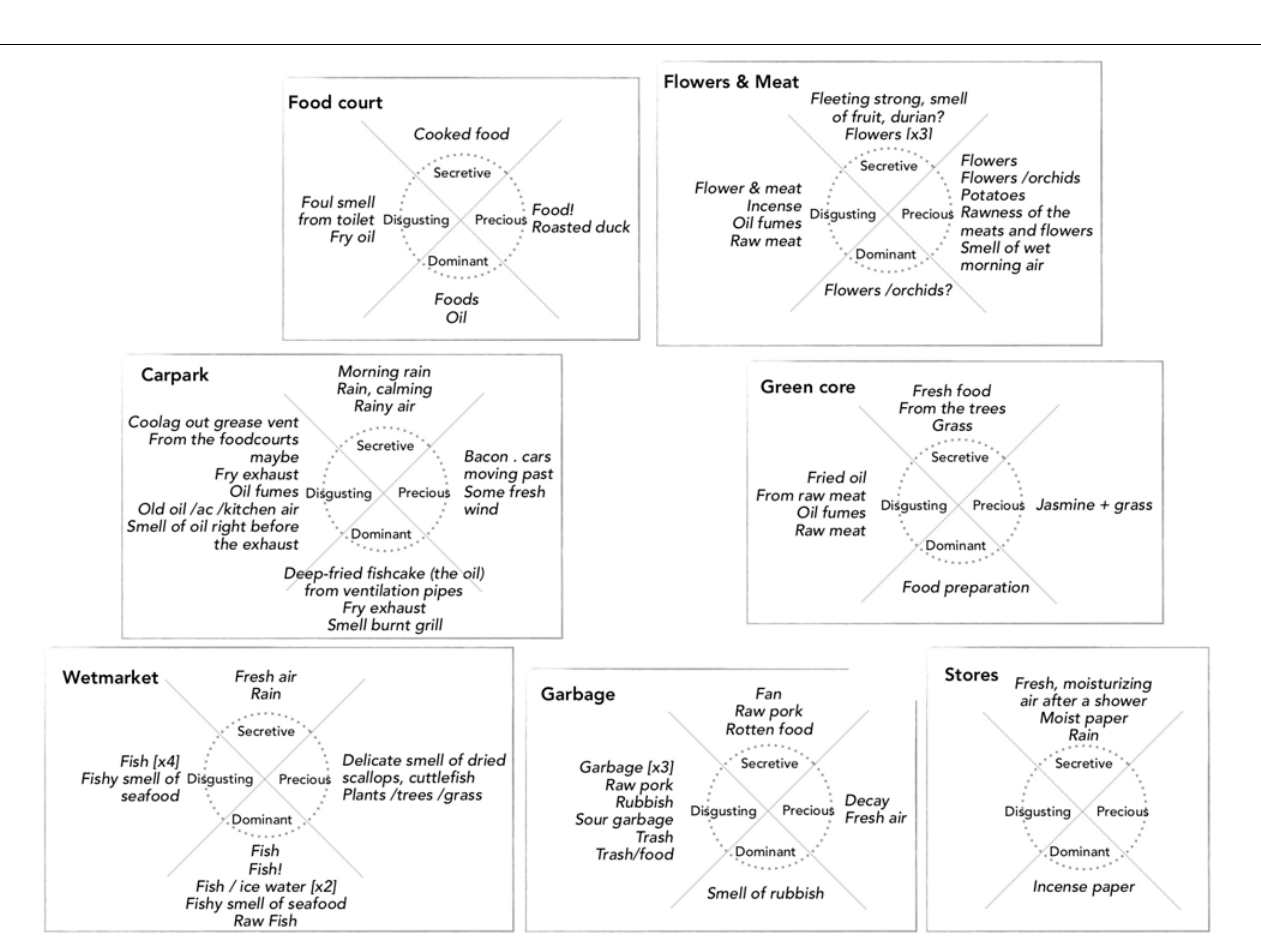
FIGURE 5 | Onsite smell source annotations ( N = 15) for seven locations; see the text for details.